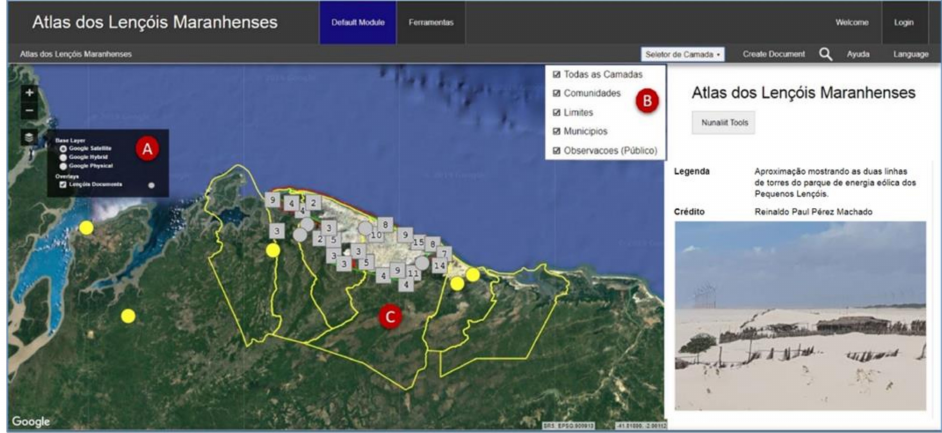
Figure 5. Layout of the Socioenvironmental Atlas of Lenç ó is Maranhenses in